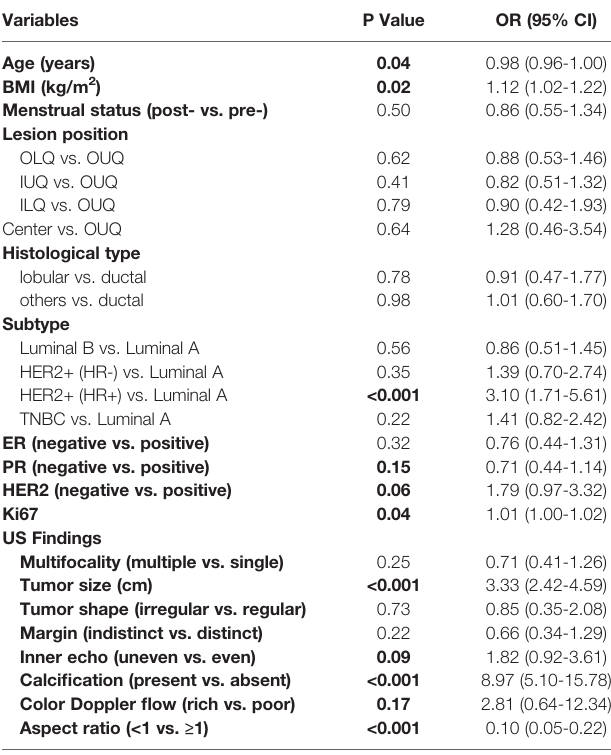
CI, con fi dence interval; OUQ, outer upper quadrant; OLQ, outer lower quadrant; IUQ, inner upper quadrant; ILQ, inner lower quadrant; HR, hormone receptor; TNBC, triple- negative breast cancer; ER, estrogen receptor; PR, progesterone receptor; US, ultrasound. Bold value are variables with P <0.2 which are candidate variables in multivariable regression analysis.